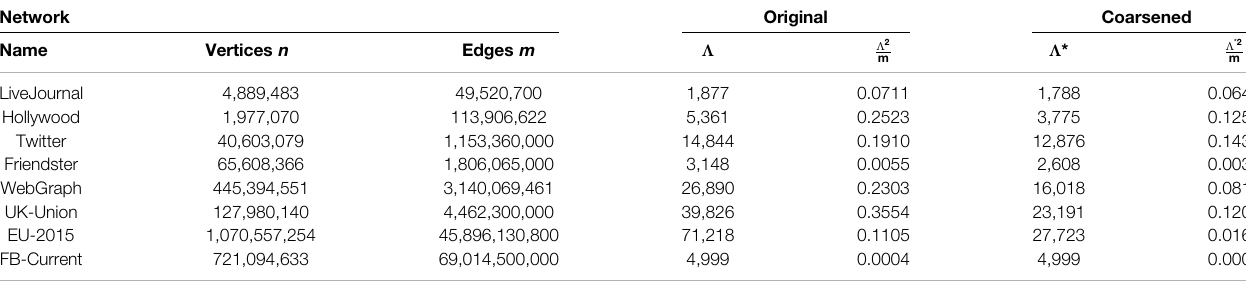
TABLE 1 | Original and coarsened input degree distributions of the test networks. Network